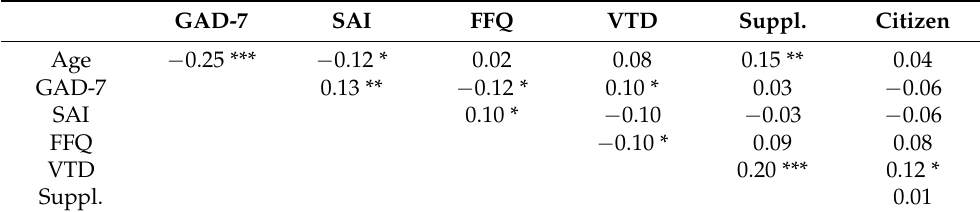
Table 3 details the two-tailed correlation coefficients between the relevant variables. Table 3. Correlation analysis between key study variables for all participants.